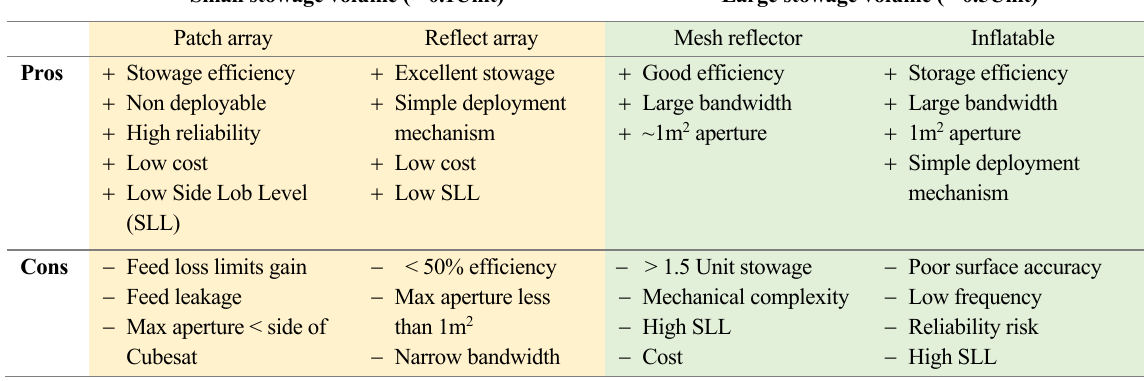
Table II enumerates their pros and cons.